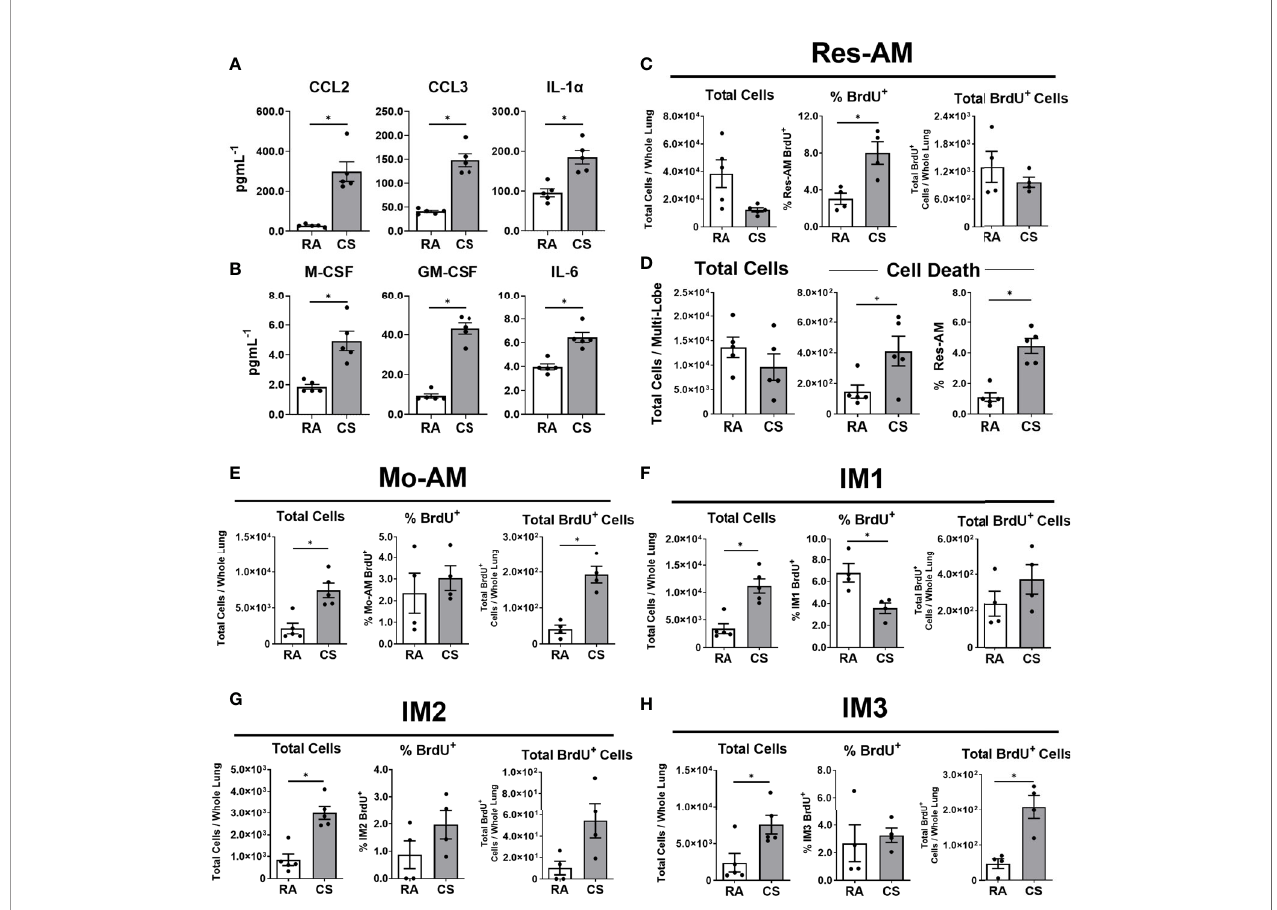
FIGURE 2 | CD11b + macrophages are recruited to the lung during cigarette smoke exposure. Female C57BL/6 mice were RA or CS-exposed for 12-weeks. Lung homogenate (A) immune mediators (CCL2, CCL3, and IL-1 a ) and (B) monocyte differentiation and macrophage survival factors (M-CSF, GM-CSF, and IL-6). BrdU was used to assess macrophage subpopulation turnover in the lung at 6-weeks CS. Data show (C) total cells, % BrdU + and total BrdU + Res-AM and (D) total cells, total dead and % dead Res-AM. Shown in (E) Mo-AM, (F) IM1, (G) IM2, and (H) IM3 are total cells, % positive and total BrdU + cells. Data show mean ± SEM, n = 4 - 5. Unpaired t test with Welch ’ s correction. RA, room air; CS, cigarette smoke. *p <